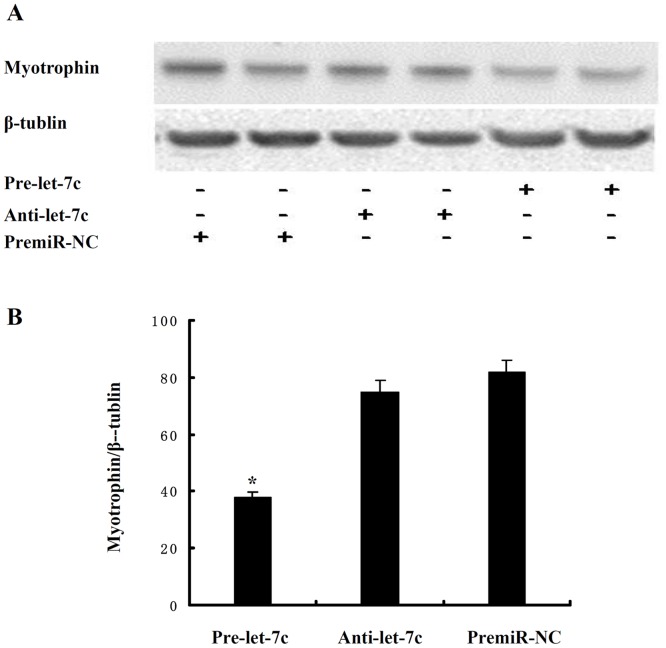
Let-7c suppresses the protein expression level of myotrophin in vitro cellular model.Cardiomyocytes were infected with PremiR miRNA precursor or Anti-miR miRNA inhibitor of let-7c (A and B). Myotrophin expression was analyzed by immunoblot 48 h after infection. *p < 0.05.